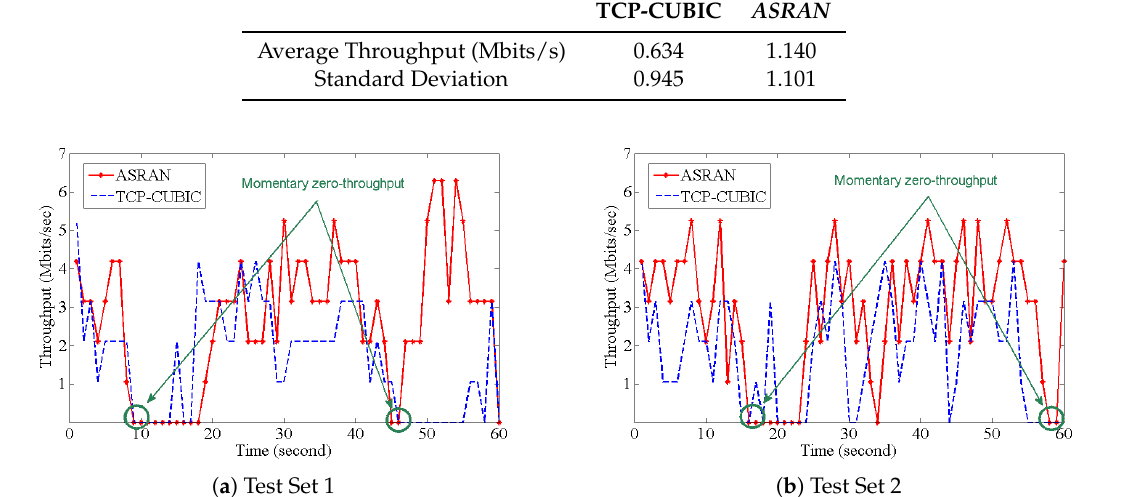
Figure 5. Throughput comparison of simultaneous experiment when transient link instability appears.